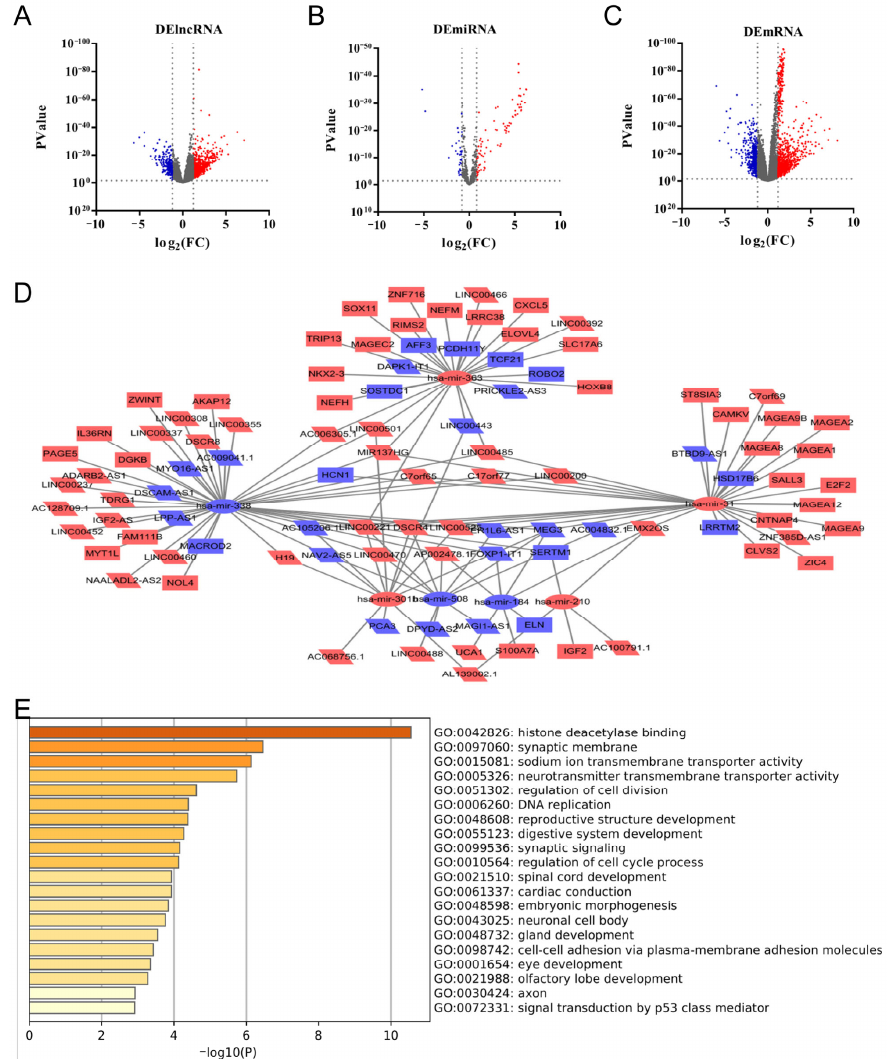
Figure 2. Triple regulatory network of lncRNA ‐ miRNA ‐ mRNA screened according to CDK1 low and CDK1 high . Red means up ‐ regulation and blue means down ‐ regulation. ( A – C ) The volcano plots describe ( A ) DElncRNAs (|log 2 FC| > 1.2, p < 0.05), ( B ) DEmiRNAs (|log 2 FC| > 0.8, p < 0.05) and ( C ) DEmRNAs (|log 2 FC| > 1.2, p < 0.05). ( D ) CDK1 ‐ related ceRNA network. ( E ) GO enrichment analysis of DEmRNAs, bar graph of enriched terms across input gene lists, colored by p values.